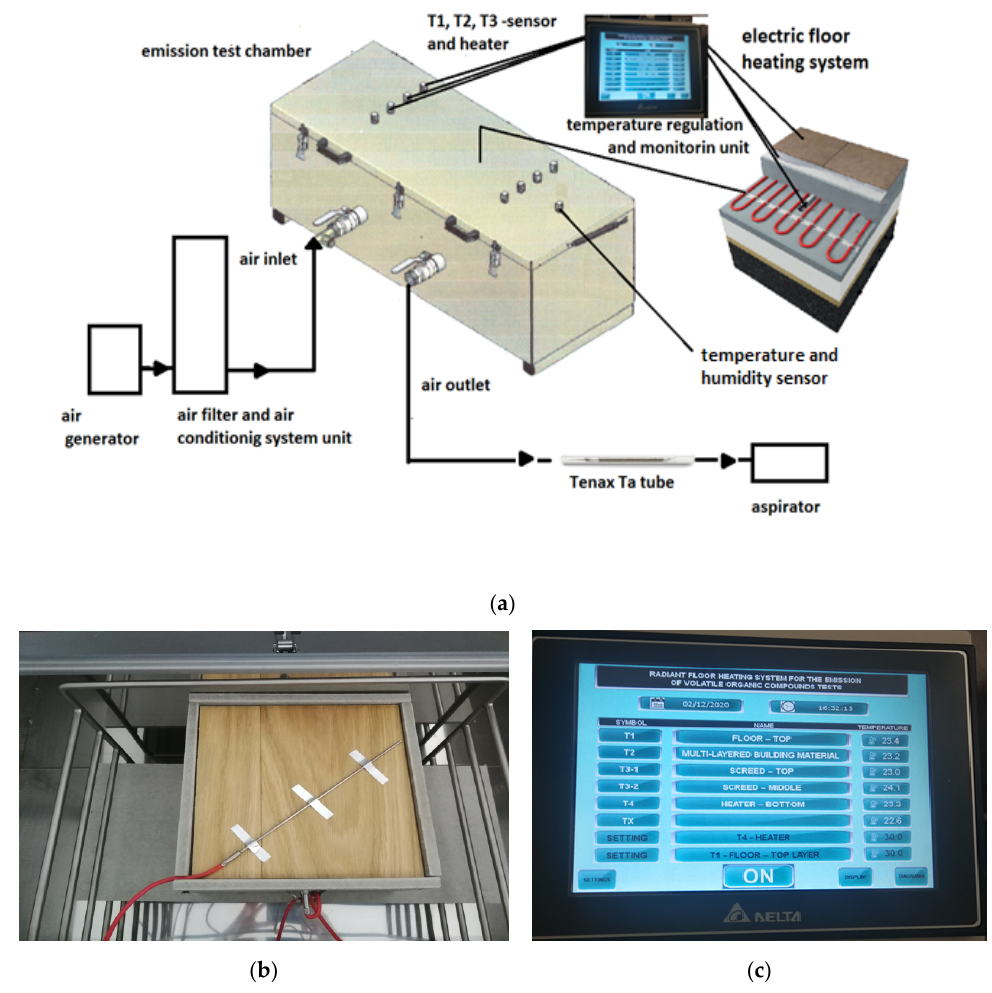
Figure 6. Test stand scheme ( a ): electrically powered radiant floor heating multilayers system ( b ) located in a test chamber; the control panel –conditioning parameters’ monitoring ( c